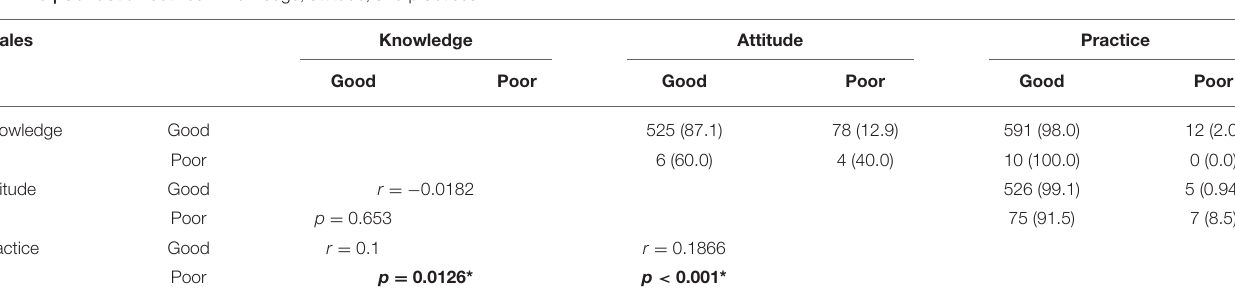
TABLE 5 | Correlation between knowledge, attitude, and practices. Scales